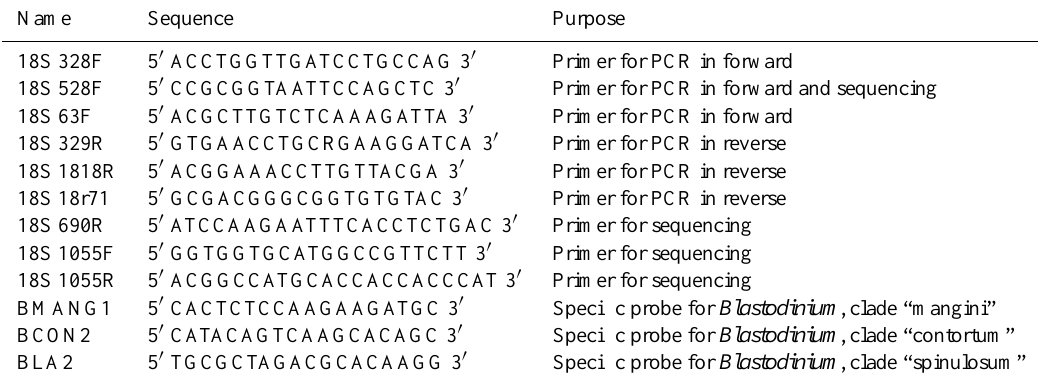
Table 1. List of primers and probes used in this